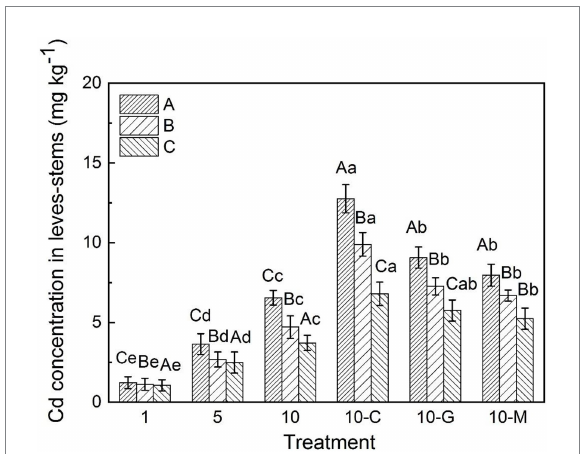
FIGURE 2 Cadmium concentration in leaves-stems of S. sudanense under different soil types. The values shown are the mean ± SE ( n = 3). Differences sampled indicated by capital letter are between soil types, and by lower-case letter are Cd/exudates related. The same letters among specific treatments are not significantly different according to Duncan’s (0.05). A, B, and C represent sandy, loamy, and clayey, respectivly. Treatments: 1, 1 mg kg − 1 cadmium ion-contaminated soil; 5, 5 mg kg − 1 cadmium ion- contaminated soil; 10, 10 mg kg − 1 cadmium ion-contaminated soil; 10-C, 10 mg kg − 1 cadmium ion-contaminated soil with the addition of 20 ml citric acid solution at 50 mmol L − 1 ; 10-G, 10 mg kg − 1 cadmium ion-contaminated soil with the addition of 20 ml glycine solution at 50 mmol L − 1 ; 10-M, 10 mg kg − 1 cadmium ion-contaminated soil with the addition of 20 ml maltose solution at 50 mmol L − 1